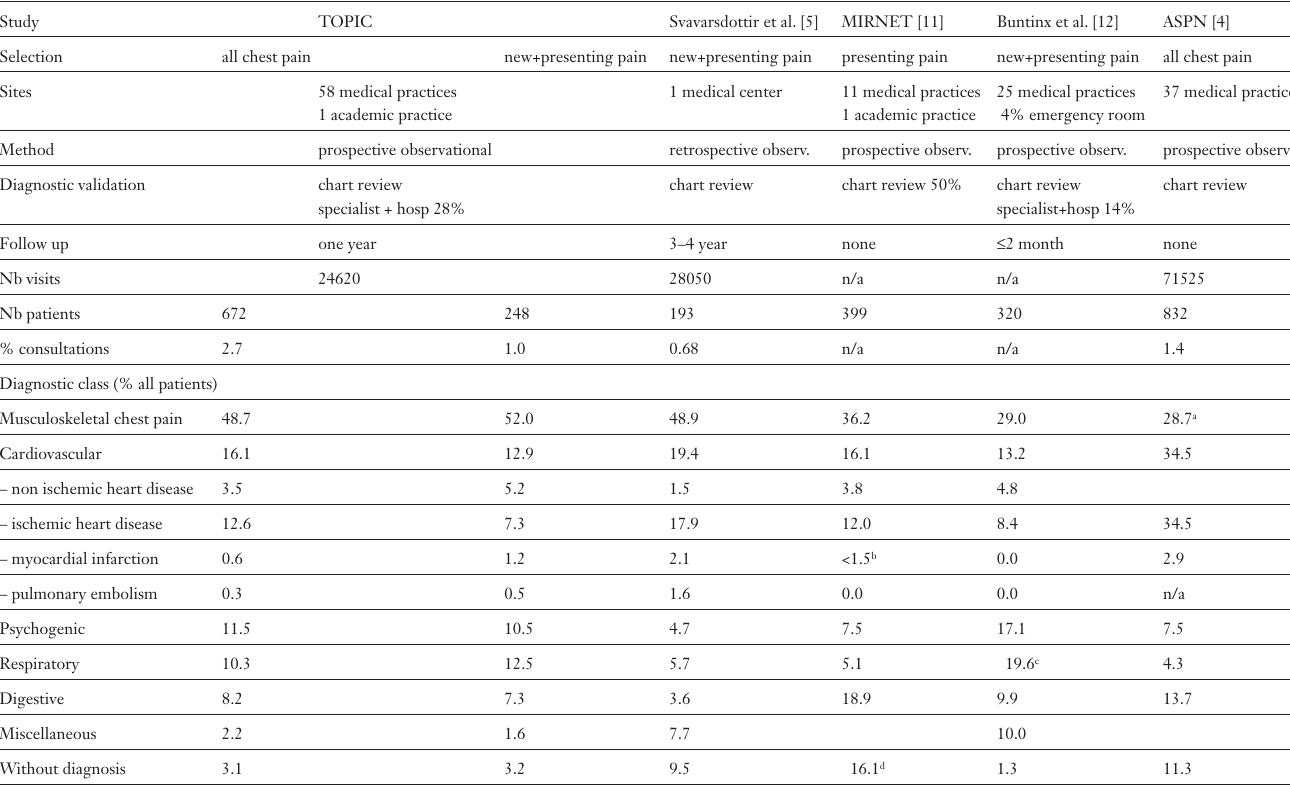
Review of chest pain epidemiology in ambulatory